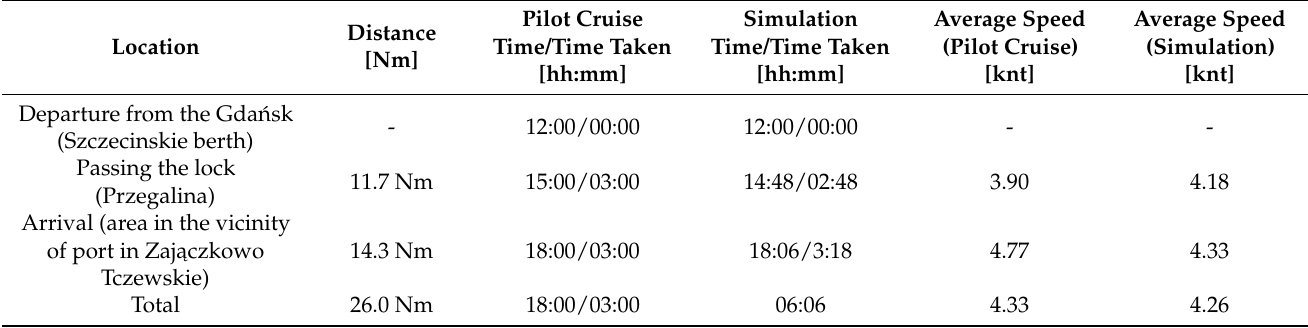
Table 2. The comparison of the simulation and pilot cruise